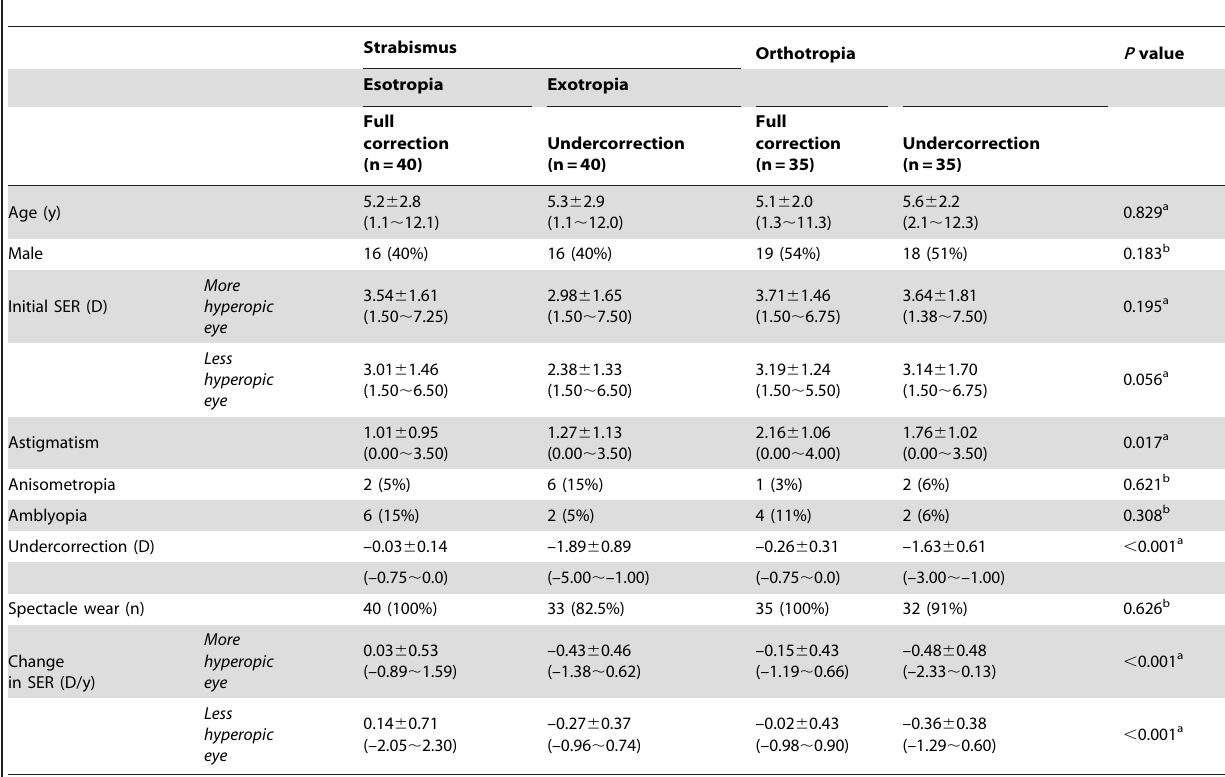
Table 1. Patients’ characteristics and change in refractive errors of age-matched and spherical equivalent refractive error-matched groups of hyperopic patients who received full or undercorrection of hyperopia, with and without